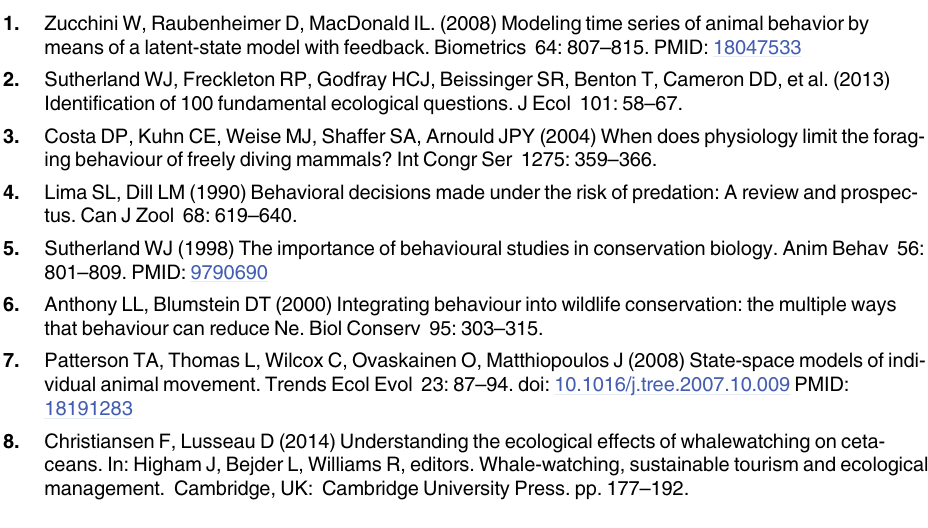
S1 Fig. Back transformed number of short dives in a surfacing bout as a function of the dive duration of the preceding long dive for minke whales during different activity states. SFT1 = surface feeding tactic I, SFT2 = surface feeding tactic II, NSF = near-surface foraging, DF = deep foraging, TRA = traveling, REST = resting). A separate GAM (GAM: Nb.short~s (Dive.pre)) was fitted to each activity state. The dashed lines represent 95% confidence